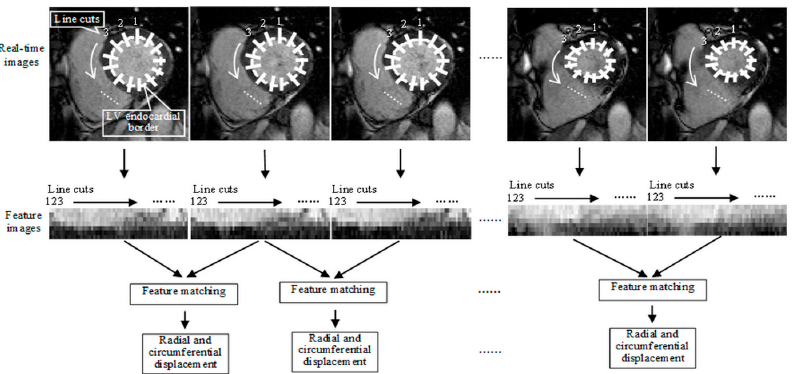
Figure 1. Illustration of feature tracking algorithm for voxel-wise measurements of LV endocardial border motion along the radial and circumferential directions. In each time frame, a set of “line cuts” normal to the LV endocardia border were interpolated from the Cartesian image voxels and arranged to form a feature image for each voxel along the LV endocardial border. The voxel-wise tracking across time frames was performed by searching for the feature images which geometrically matched best. The radial displacement was given by the radius change of each voxel between two neighboring image time frames and the circumferential displacement by the angular